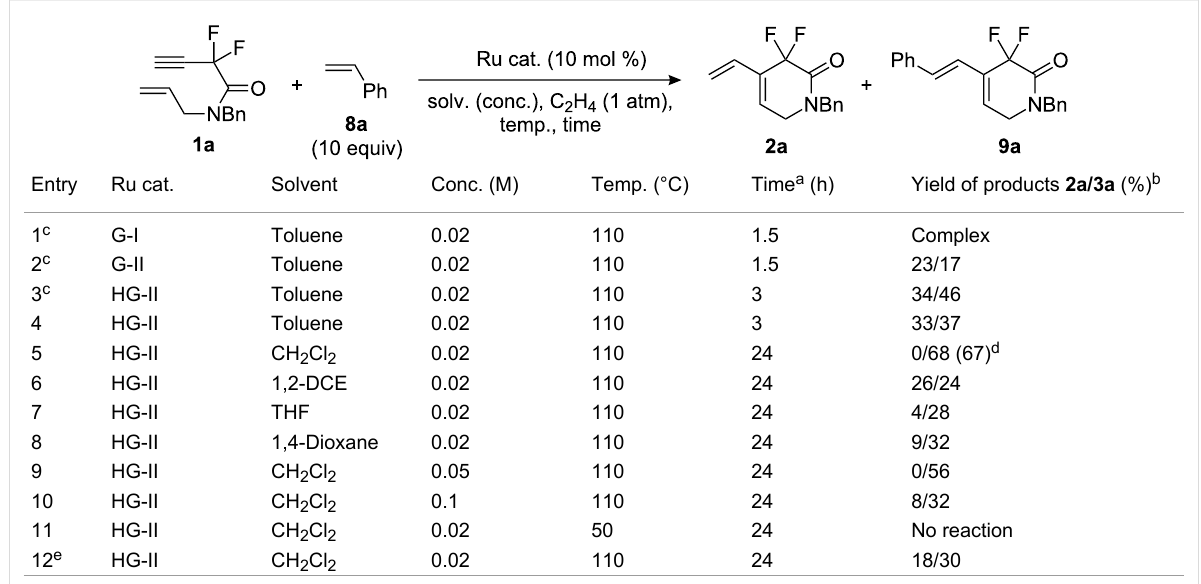
Table 3: Screening of CM–EYM tandem reaction.